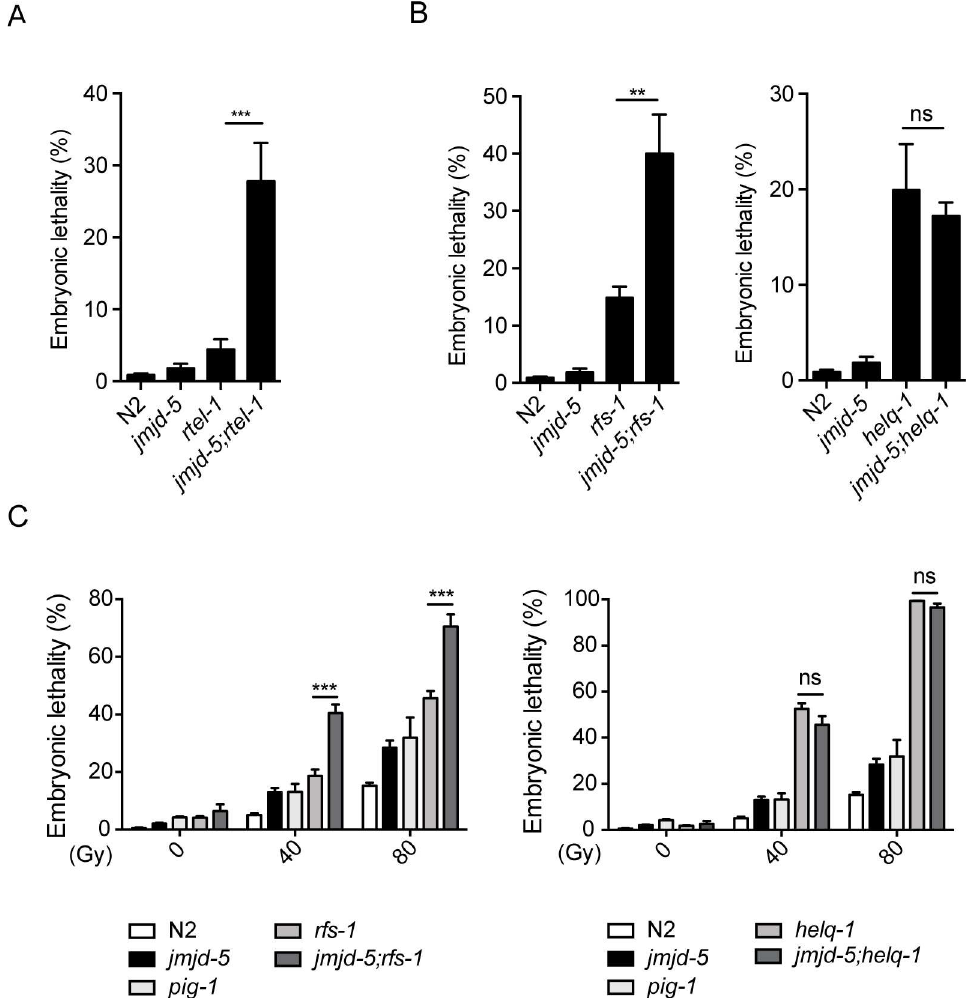
Fig 5. Genetic interaction analysis of jmjd-5 with rtel-1 , helq-1 and rfs-1 . (A) Percentageof embryonic lethality measuredin the indicatedstrains, grown at 25˚C for one generation.Embryos from adult animals grown at 20˚C were plated at 25˚C and their ability, once adult, to produceviable progenywas measured.(B) Percentageof embryonic lethality measuredin the indicatedstrains, grown at 25˚C for one generationas describedin (A). (C) Percentage of embryonic lethality in the indicatedstrains after treatment of young adults worms with 0, 40 and 80 Gy. pig-1(gm344) is used as positive control. Data are represented as means ± sem from at least 3 biologicalindependentexperiments. *** p < 0.005, ** p < 0.01,n.s. = not significant,with two-tailed,